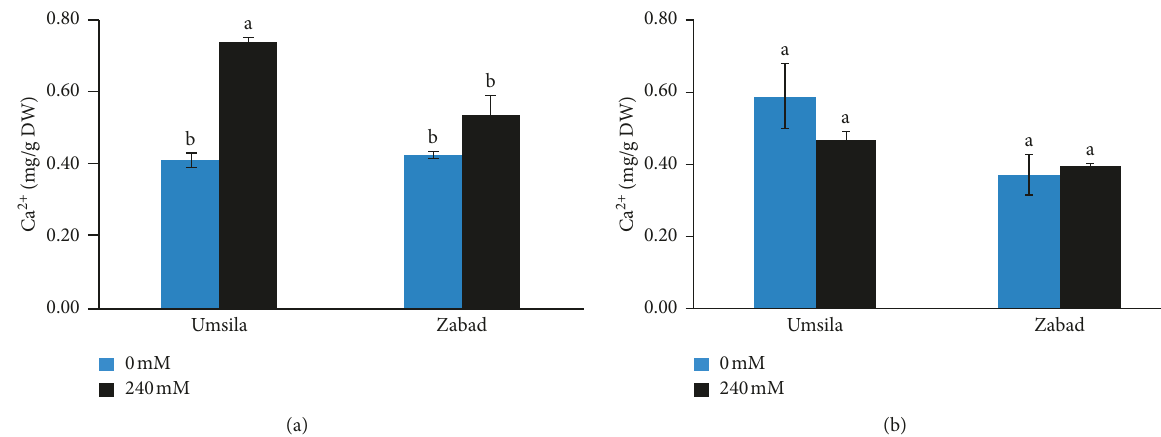
Figure 6: Effect of salinity on the calcium (Ca +2 ) concentration in leaves (a) and roots (b) of date palm seedlings when grown under control and salinity conditions. Bars represent mean ± SE ( n � 3). Bars with the same letter are not significant at p ≤ 0 . 05.